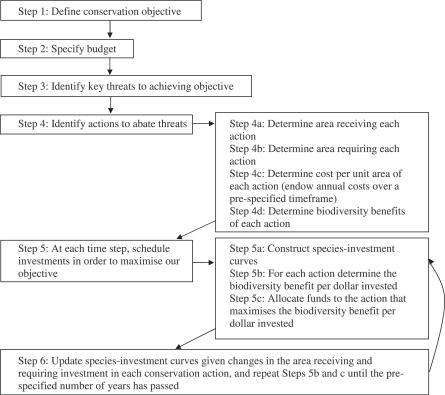
Decision Steps Involved in the Conservation Investment Framework